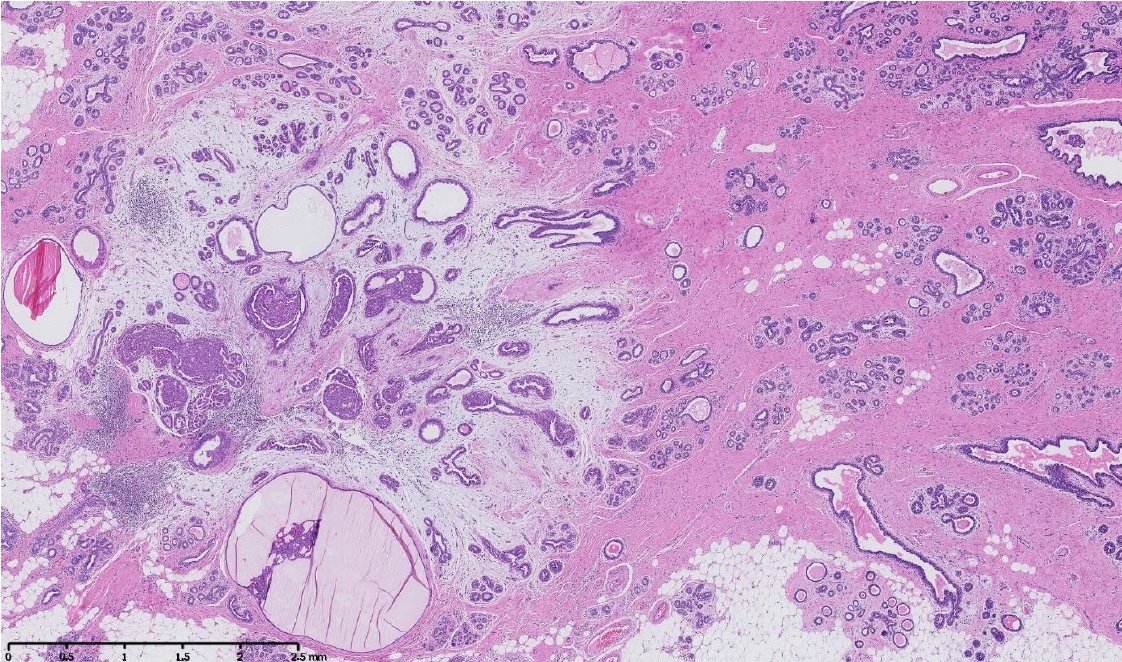
Figure 3. Hematoxylin and eosin staining: at low magnification, the breast parenchyma shows a fibrous stroma containing an irregularly shaped lesion with a fibro-myxoïd dense stroma and inflammatory changes containing cystic ducts and hyperplastic